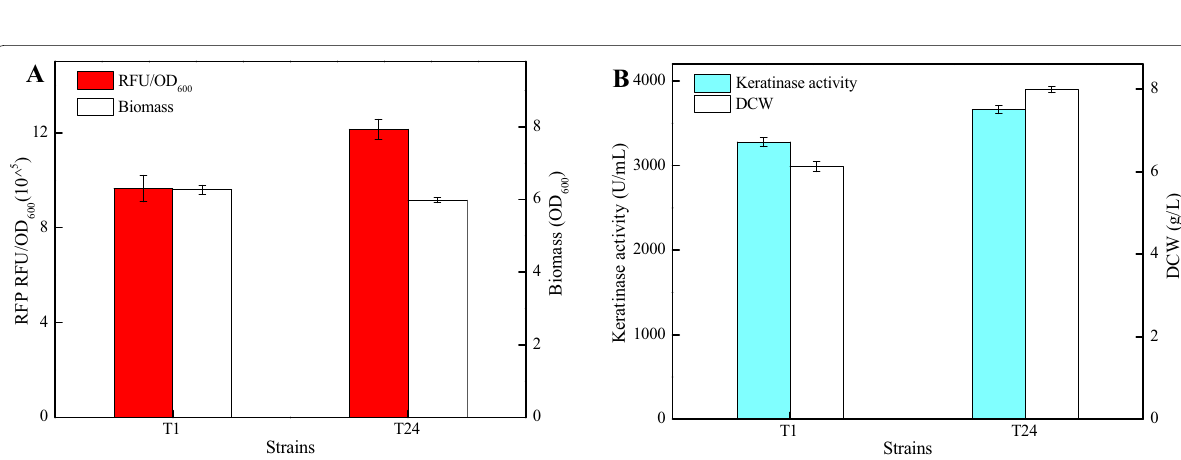
Fig. 6 Application of terminator T24 in protein expression. A RFP fluorescence intensities and cell biomasses of recombinant strains with different terminators (T1, T24). B Keratinase activities and cell biomasses of recombinant strains with different terminators (T1,